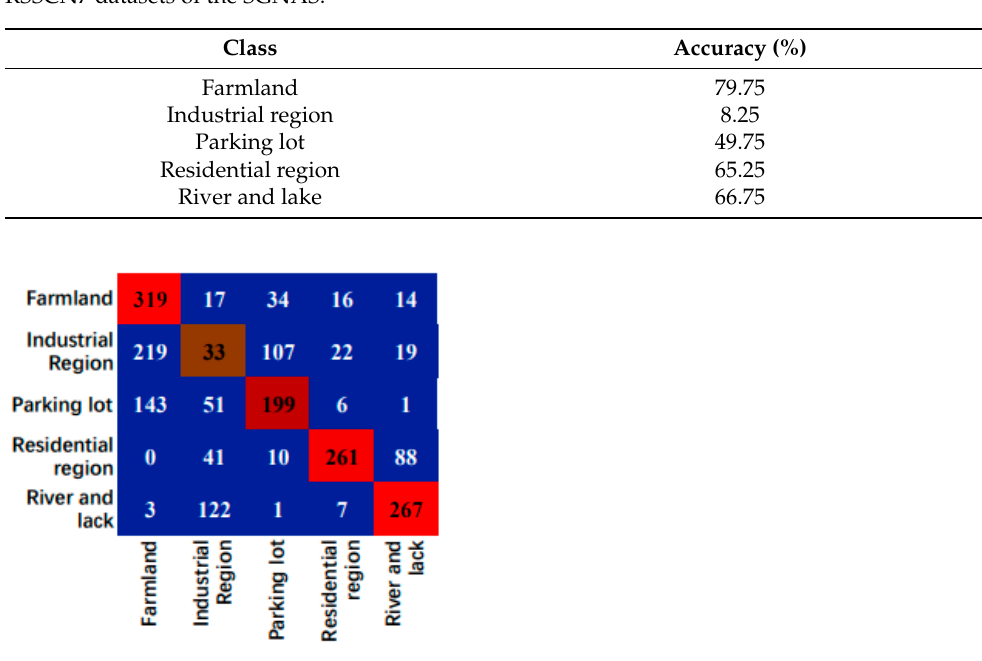
Table 4. Accuracy of various scenes in the cross-domain scene classification of the SIRI-WHU and RSSCN7 datasets of the SGNAS.